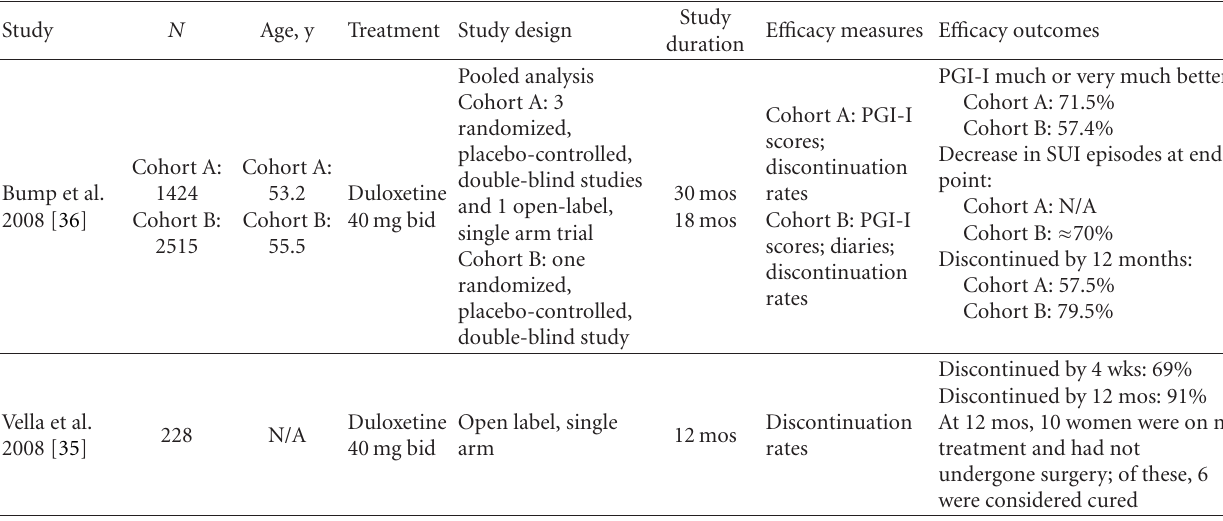
Table 2: Summary of pharmacotherapy